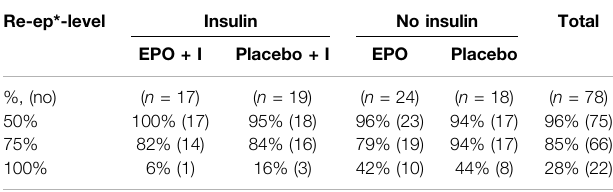
TABLE 6 | Overview of the results of the 100% reepithelialization level of the study wound.